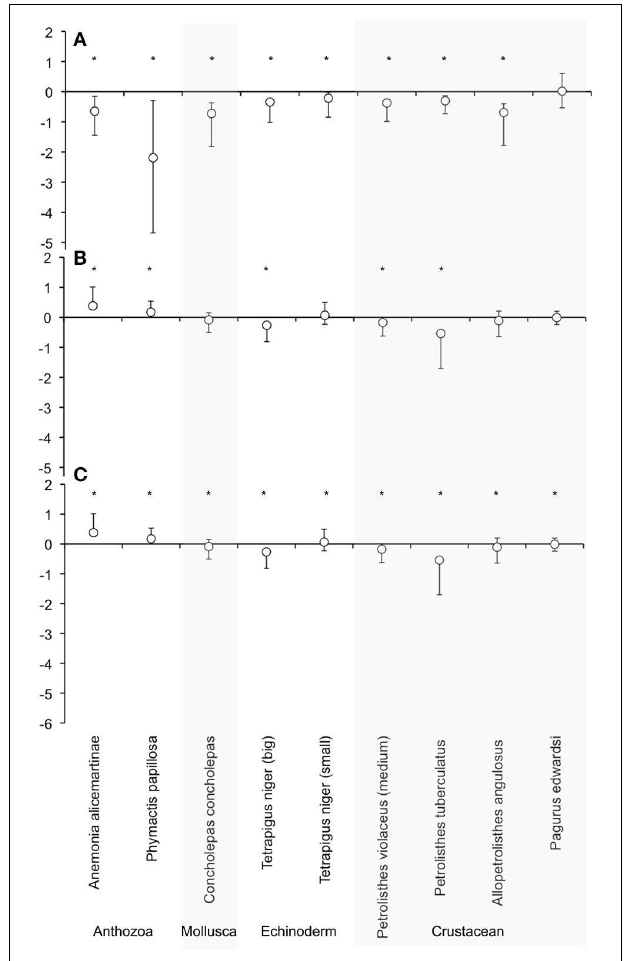
FIGURE 1 | Effect size off of the respiration rate of each species calculated with dry weight after 6 days. Where (A) is L O2 L CO2 , (B) H O2 H CO2 , and (C) L O2 H CO2 treatment vs. H O2 L CO2 . LnRR = ln(treatment - H O2 L CO2 ) ± Confidence interval (after Kroeker et al., 2010). * Marks the significant difference between H O2 H CO2 and experimental treatments of the effect size.